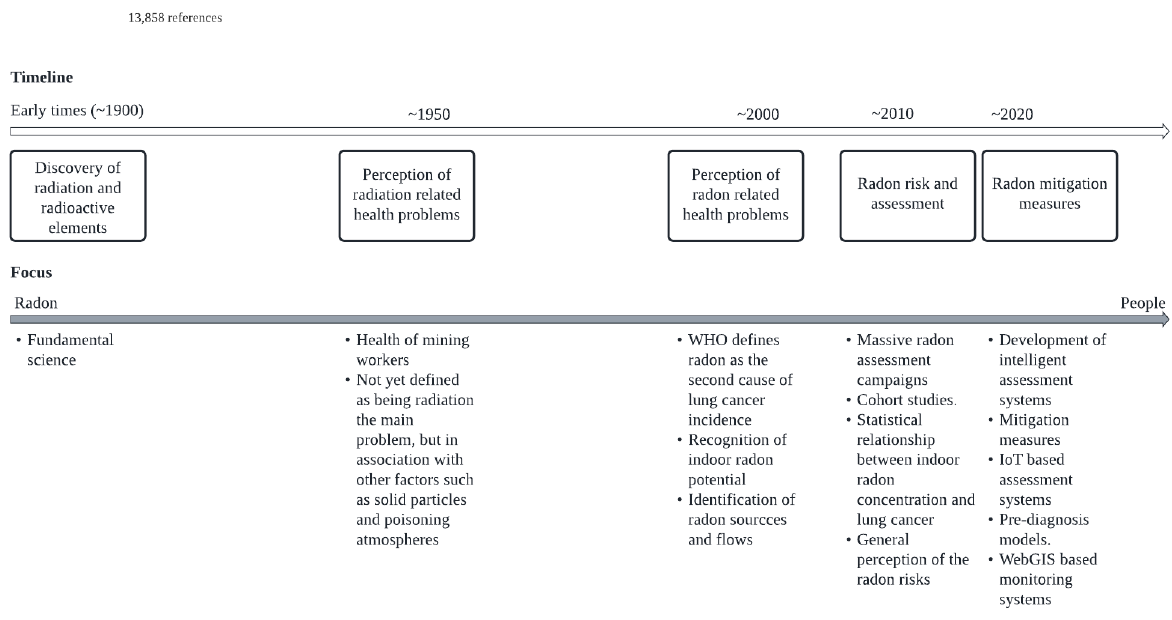
Figure 4. Summary of the main achievements concerning the evolution of radon science.